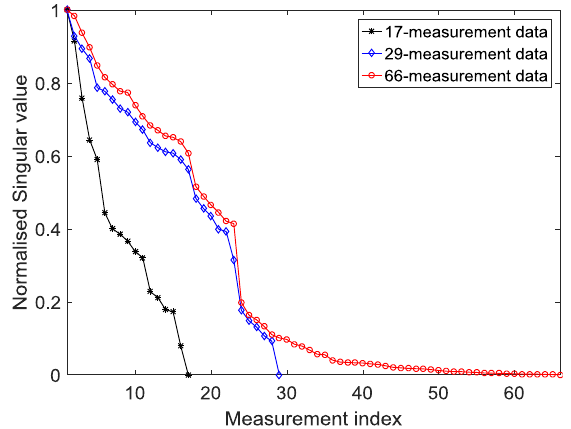
Figure 8. Singular value decomposition. The capacitance data of neighboring electrode pairs comprise 17 groups; that of neighboring and opposing electrode pairs 29 groups; and, that of the original capacitance data 66 groups.